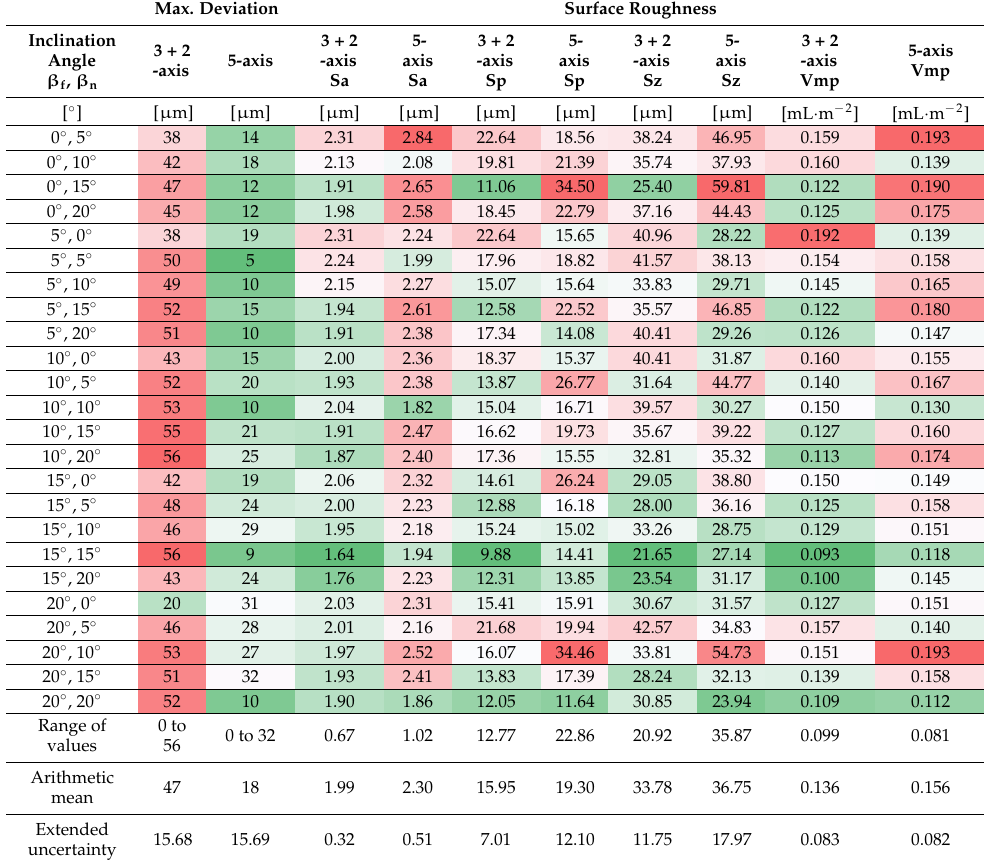
Table 4. Maximum deviation and surface roughness during 3 + 2-axis and 5-axis machining (where green are positive results and red negative